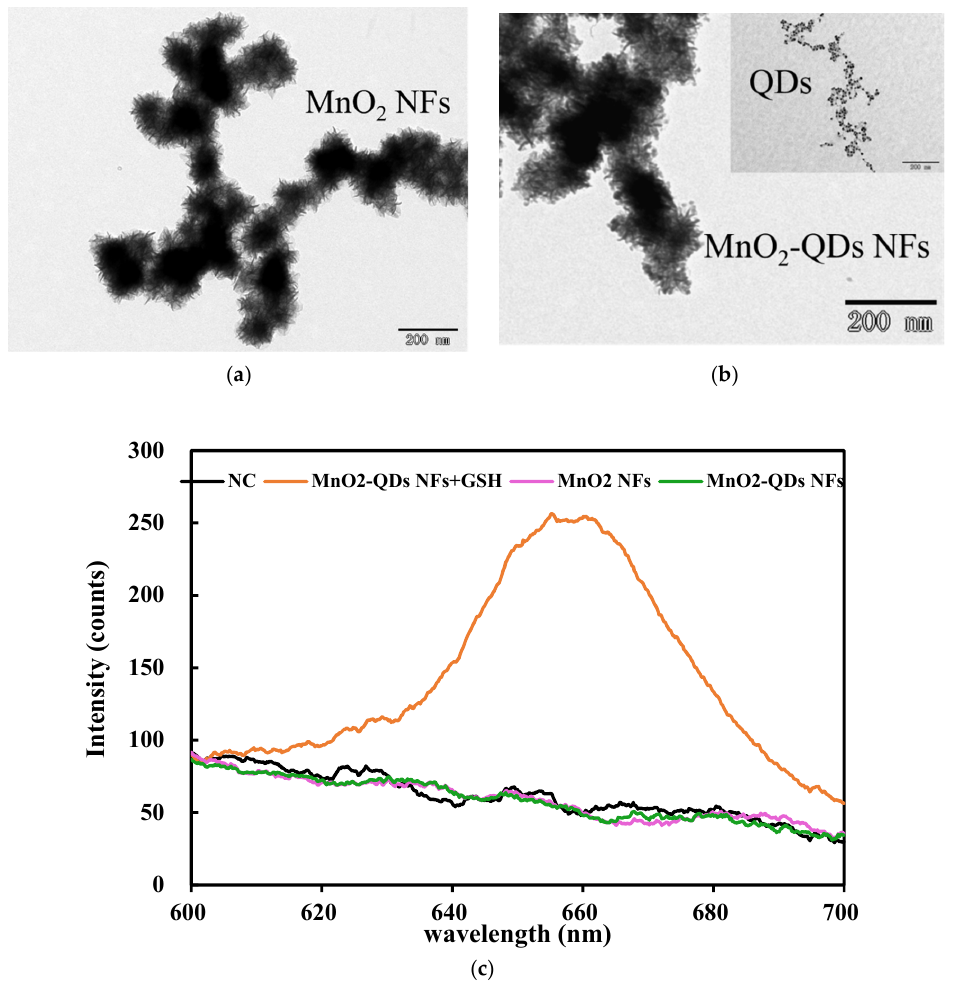
Figure 2. ( a ) The TEM image of the MnO 2 NFs; ( b ) The TEM image of the MnO 2 -QD NFs. The inset is the TEM image of the QDs; ( c ) The fluorescent spectra of the QDs, MnO 2 NFs, MnO 2 -QD NFs, and the mixture of the MnO 2 -QD NFs and